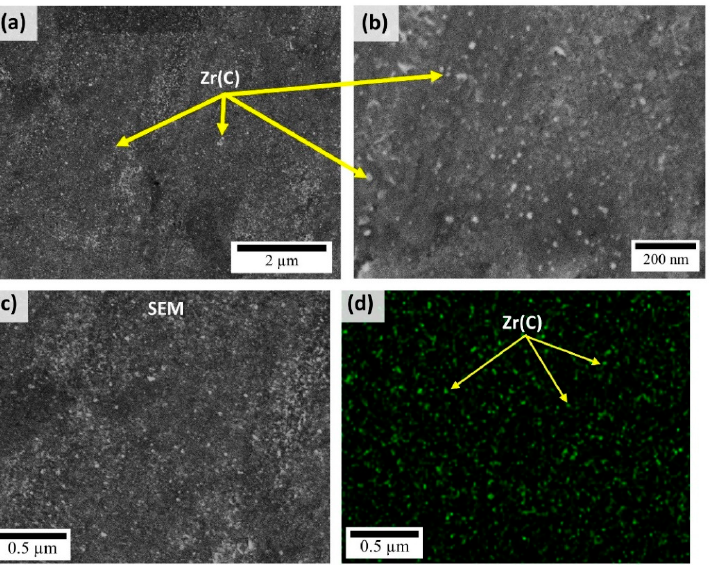
Figure 10. Nanoparticle dispersion in the Fe matrix ( a , b ) SEM secondary electron micrographs at progressive resolutions of the sintered Fe-5 vol.% ZrC powder samples, ( c ) SEM secondary electron micrograph of an area for collecting ( d ) EDS elemental map of Zr signals from ZrC showing the distribution of NPs.